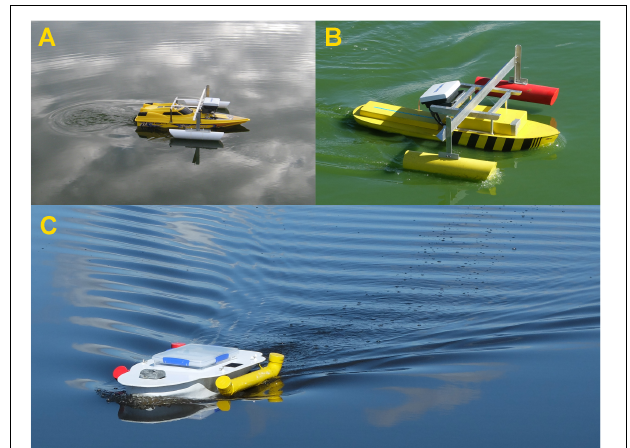
FIGURE 2 | Design iterations of the sonar profiling ROV (detailed specifications in Table 1 ). (A) The prototype was an off-the-shelf speed boat, fitted with a frame to mount the sonar unit and stabilizers to the boat. (B) Redesign of the boat with a more robust deep V-shaped hull, with frame for sonar and stabilizers. (C) Current boat design with U-shaped hull and sonar mounted inside. ( Figure 2A ), the first redesign ( Figure 2B ), to the final design ( Figure 2C ) can be found in Table 1